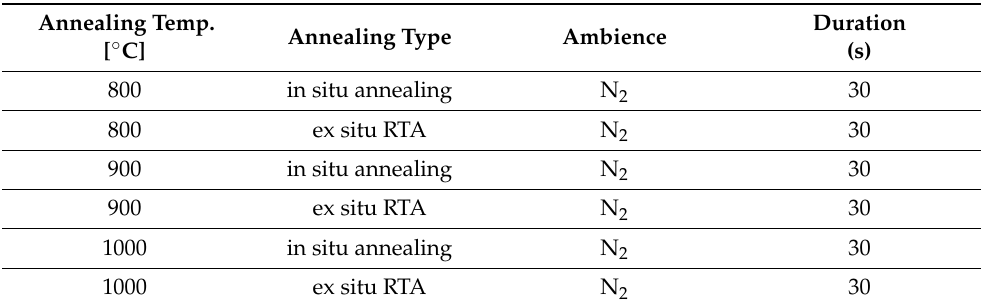
Table 2. The annealing condition to investigate the effect of annealing temperature for the sample grown at 690 °C.